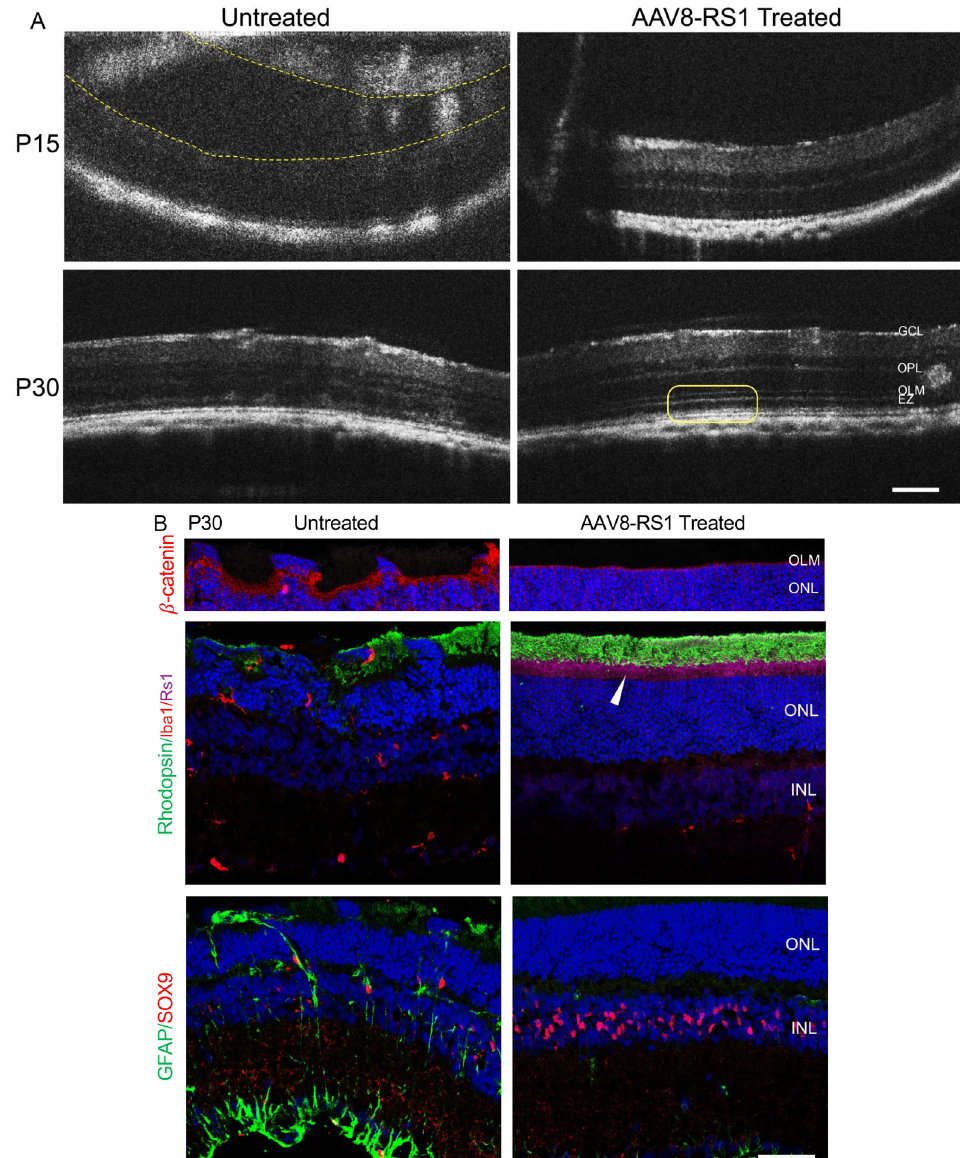
Figure 8. Effects of an intravitreal injection of AAV8-RS1 into the eyes of Rs1 -/Y rat. AAV8 vector expressing RS1, scAAV8-hRS/IRBP-hRS was delivered into the eyes of Rs1-KO rats. Contralateral eyes were untreated and served as the negative control. Intravitreal injection was done at P5 or P6 with 2 x 10 10 viral genome per eye. ( A ) Optical coherence tomography (OCT) was performed at P15 and P30. At P15, no or substantially reduced formation of retinal cavities was found, and the retinal lamination was well-preserved in the treated eye (N = 7). At P30, eyes that received AAV8-RS1 displayed a distinct laminar structure, including the inner retina, outer plexiform layer (OPL), outer nucelar layer (ONL), and four outer retina reflective bands (ORRBs) (yellow box), while untreated contralateral eyes showed highly disrupted laminar structure. Scale bar = 200 μm. ( B ) Immunohistochemistry for retinal and inflammatory markers was performed at P30. Remarkable rescue effects have been found on the structure of Rs1 -/Y rat retinas after AAV8-RS1 gene delivery. Treated retinas showed RS1 expression (purple, white arrowhead ), with comparable levels to WT retina (Figure 5), on the inner segments of photoreceptors and bipolar cells, while untreated eyes lacked RS1 expression. The treated retina displayed intact OLM (b-catenin, red). Rod outer segments (Rhodopsin, green) were well-preserved. In addition, we demonstrated that RS1 delivery prevented microglial (Iba1, red) and Müller glial (GFAP, green) alterations and cell death of Müller glia (SOX9, red).